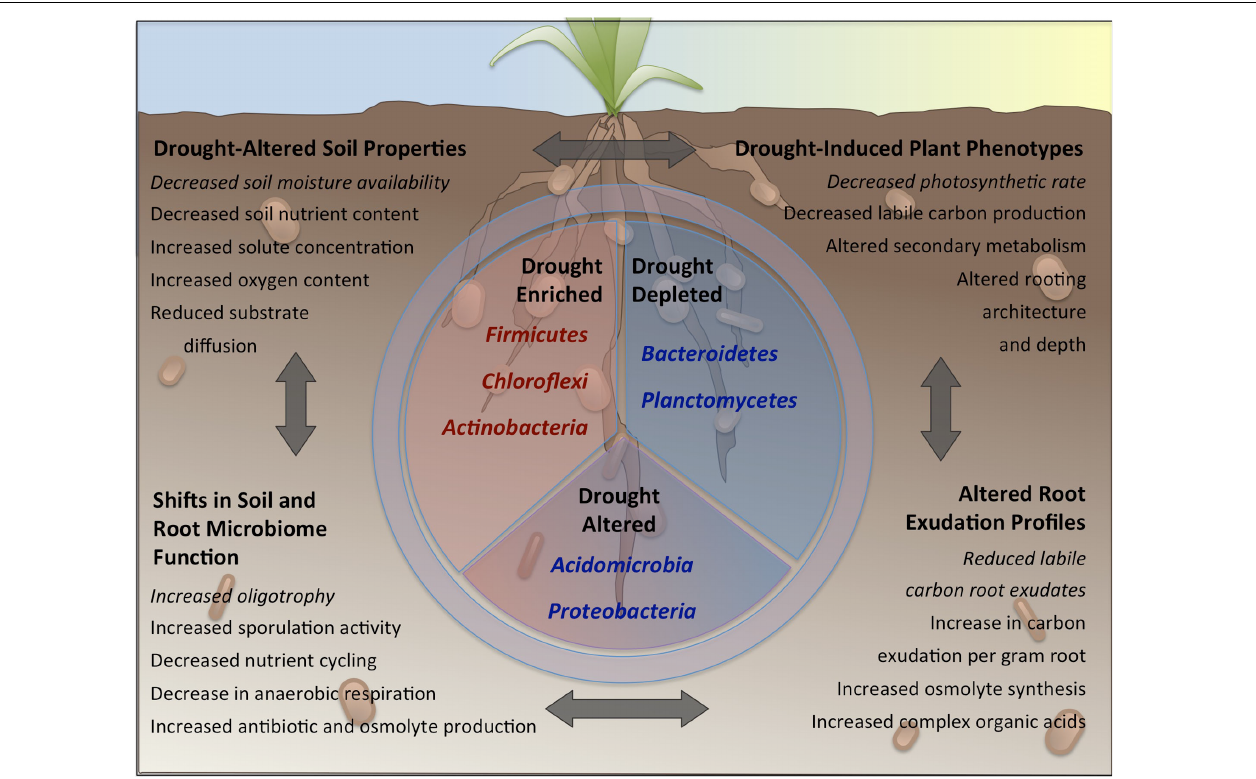
FIGURE 1 | The effects of drought on soils, plants and their associated bacterial communities. Drought induces shifts in soil physicochemistry (upper left), plant phenotype (upper right), root exudation (lower right) and soil and rhizosphere microbiome function (lower left). These shifts are capable of influencing one other; for instance decreases in soil moisture availability (upper left) leads to a decrease in the rate of plant photosynthesis (upper right), which in turn leads to a reduction in the rate of labile carbon exudation to the rhizosphere (lower right) and a greater prevalence in bacteria with oligotrophic life-strategies (lower left), who are less reliant on such simple carbon sources. These shifts lead to a selection for specific phyla (center panel) within the soil, rhizosphere and root microbiome, including enrichment for many Gram-positive, oligotrophic (middle left) phyla, and concurrent depletion of many Gram-negative, copiotrophic (middle right) phyla. Members of other phyla exhibit a more balanced mixture of enrichment and depletion (middle